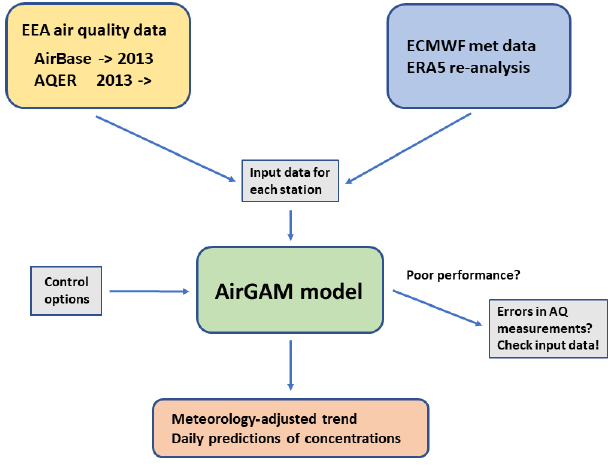
Figure 1. AirGAM data flow scheme.